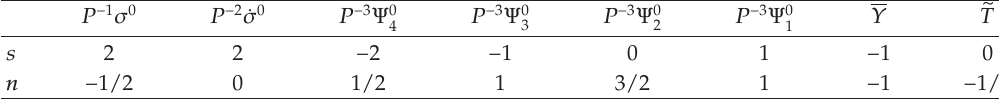
Table 2: Rank and density